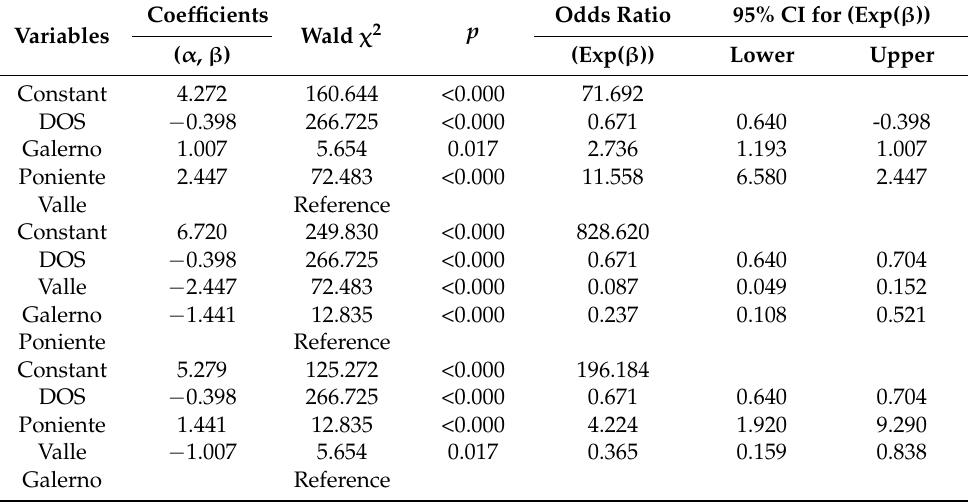
Table 5. Estimation of the multiple logistic regression parameters for cultivars (Galerno, Poniente, and Valle) and days of storage (DOS) as factors influencing the probability of marketability.